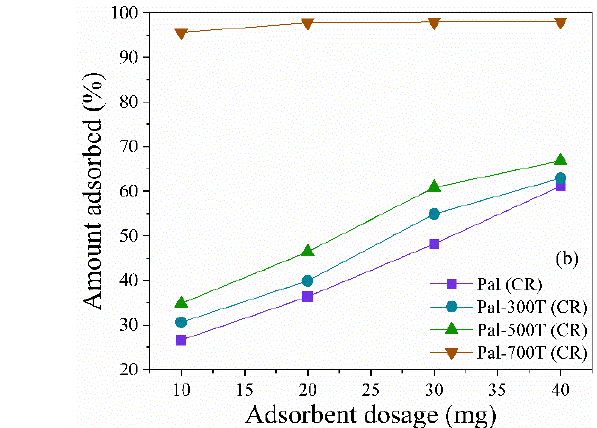
Figure 10. Effect of the amount of adsorbent on the adsorption of ( a ) CV and ( b ) CR on palygorskite before and after heat treatment.